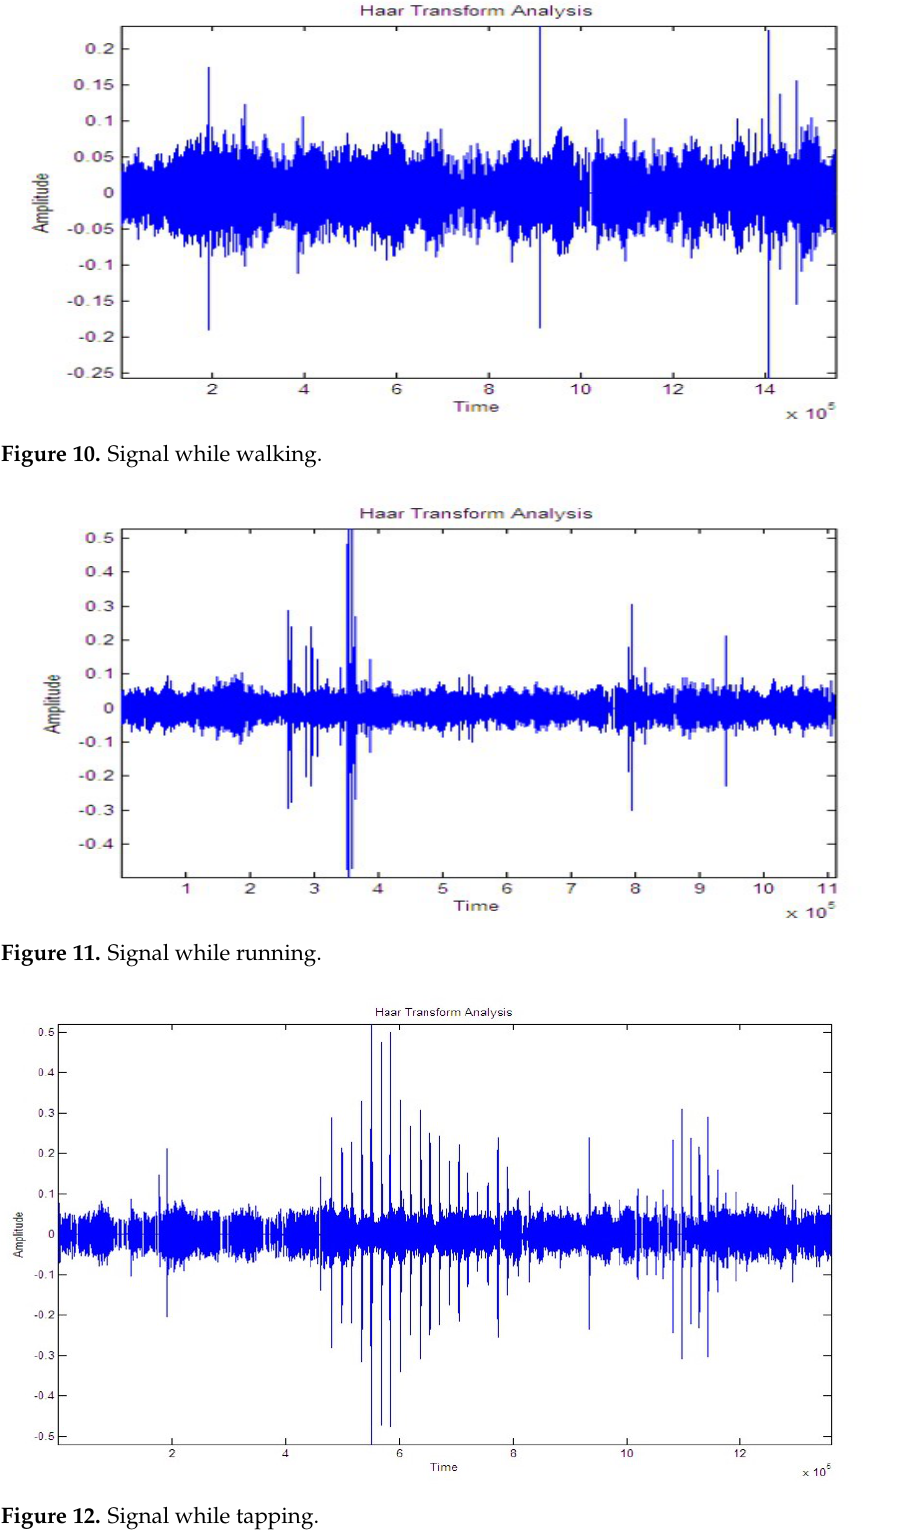
Figure 12. Signal while